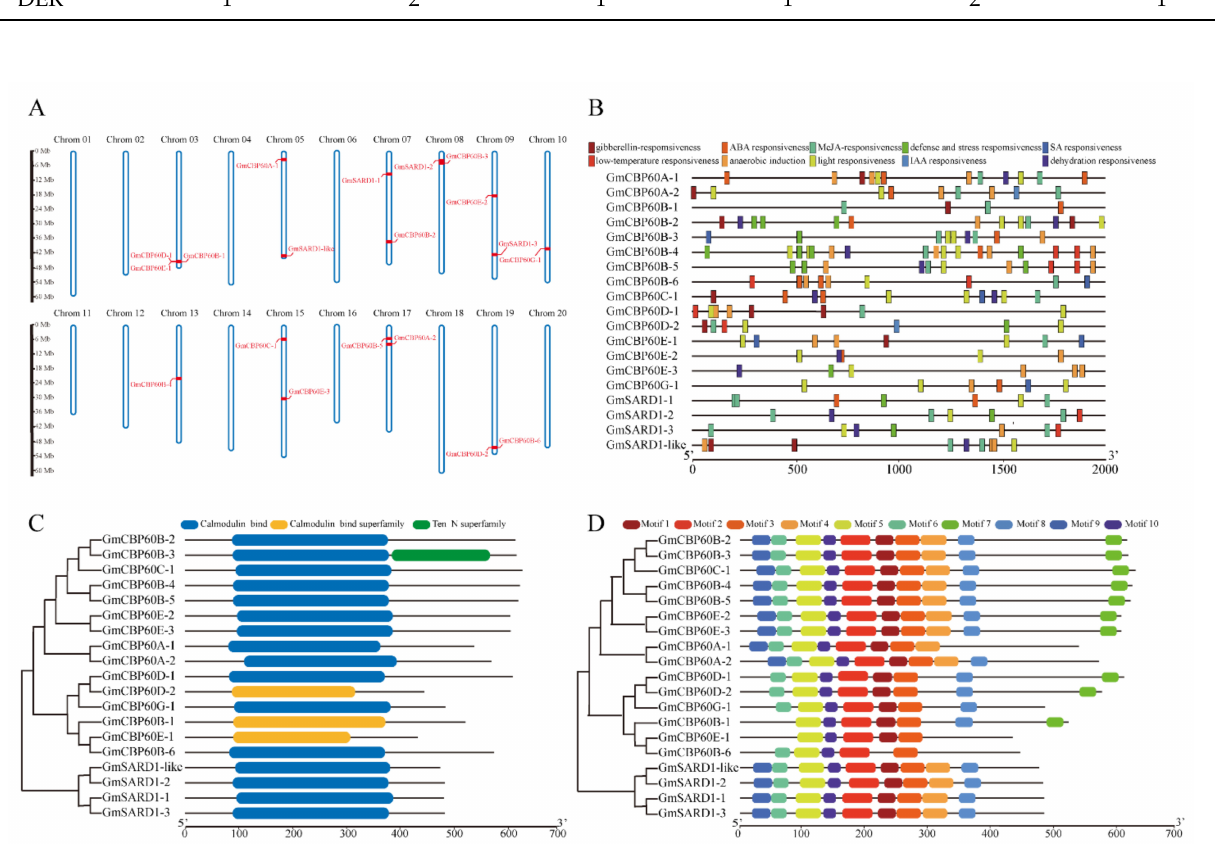
Figure 2. Chromosomal distribution, cis -regulatory elements, domains, and motifs of the GmCBP60 genes. ( A ) The chromosomal distributions of the GmCBP60 genes in the soybean genome. The red lines point the position of GmCBP60 genes. The chromosome names were set at the top of the chromosomes; ( B ) Cis -elements in the GmCBP60 gene promoter regions. Different cis -elements were indicated by distinct colored round rectangles; ( C ) Pfam domain present in soybean GmCBP60 family; ( D ) Schematic distributions of the conserved motifs among GmCBP60 genes. Each colored box represents a motif in the